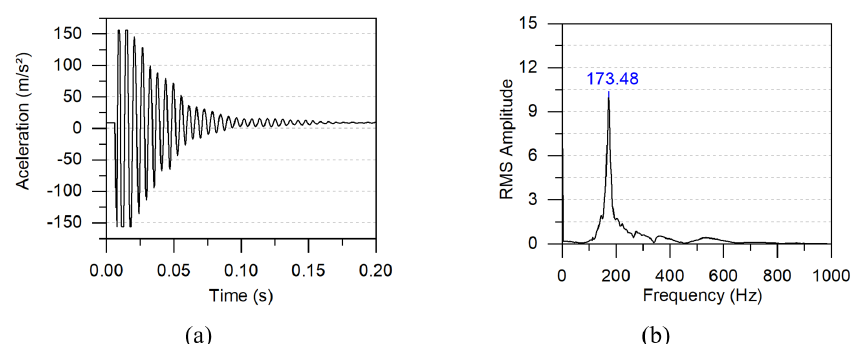
Figure 11. Accelerometer signal in (a) time and (b) frequency domain